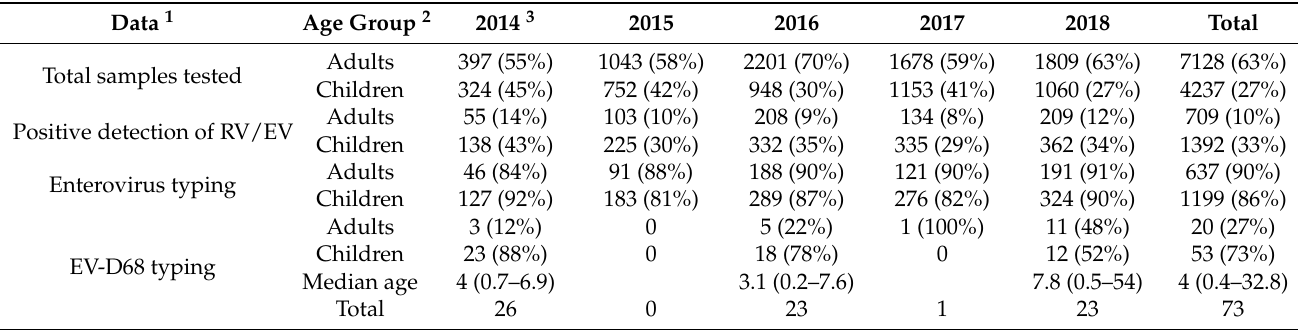
Table 1. Yearly screening for rhinovirus/enterovirus (RV/EV) in respiratory samples from patients presenting to the University Hospital, Clermont-Ferrand, France.